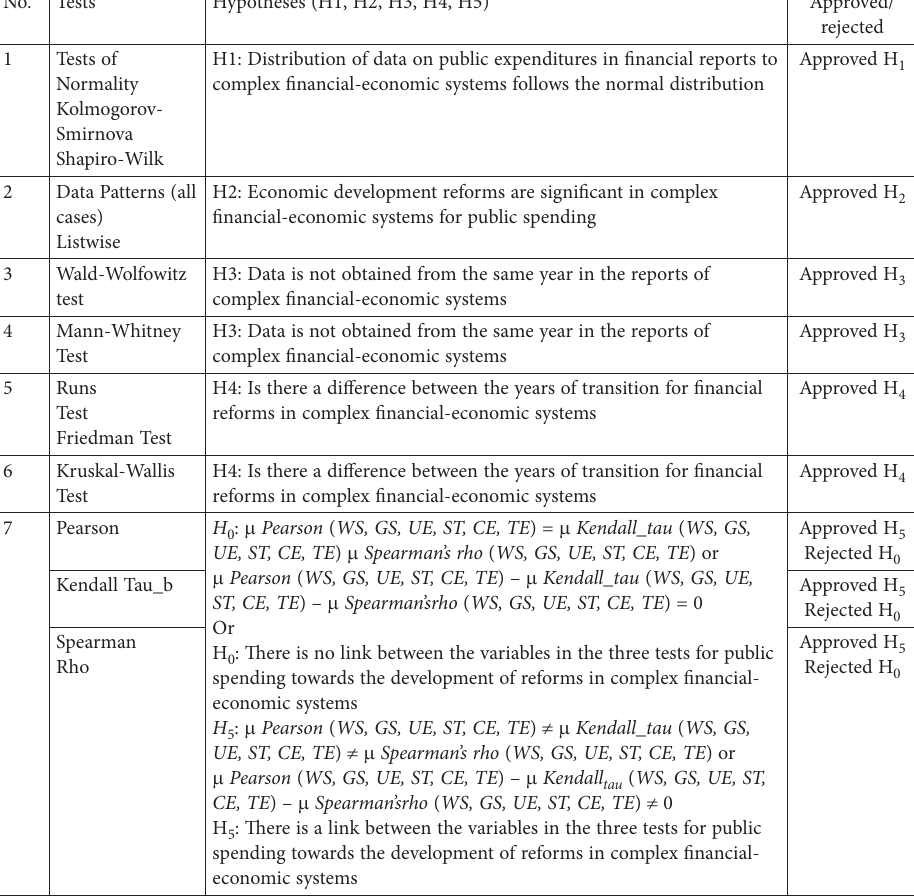
Table 12. Elaboration validation of the hypotheses (H1, H2, H3, H4,